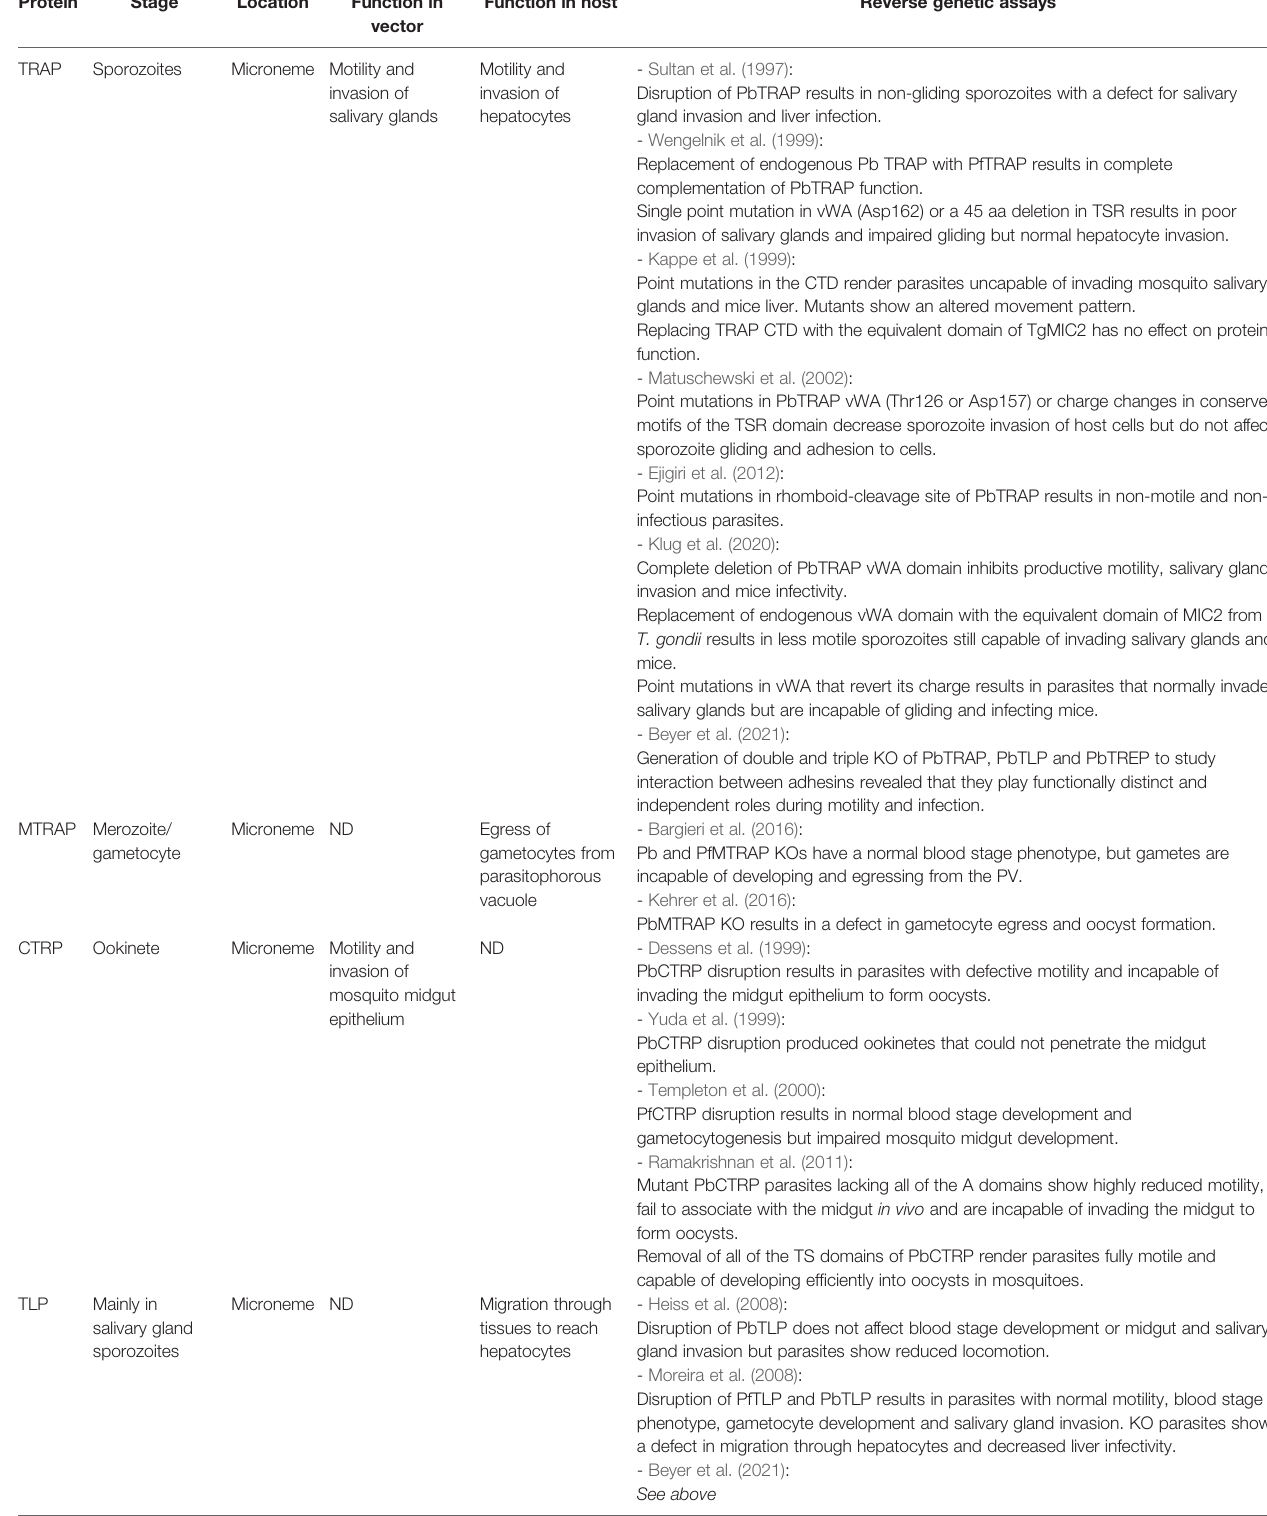
TABLE 1 | TRAP- family proteins in Plasmodium .